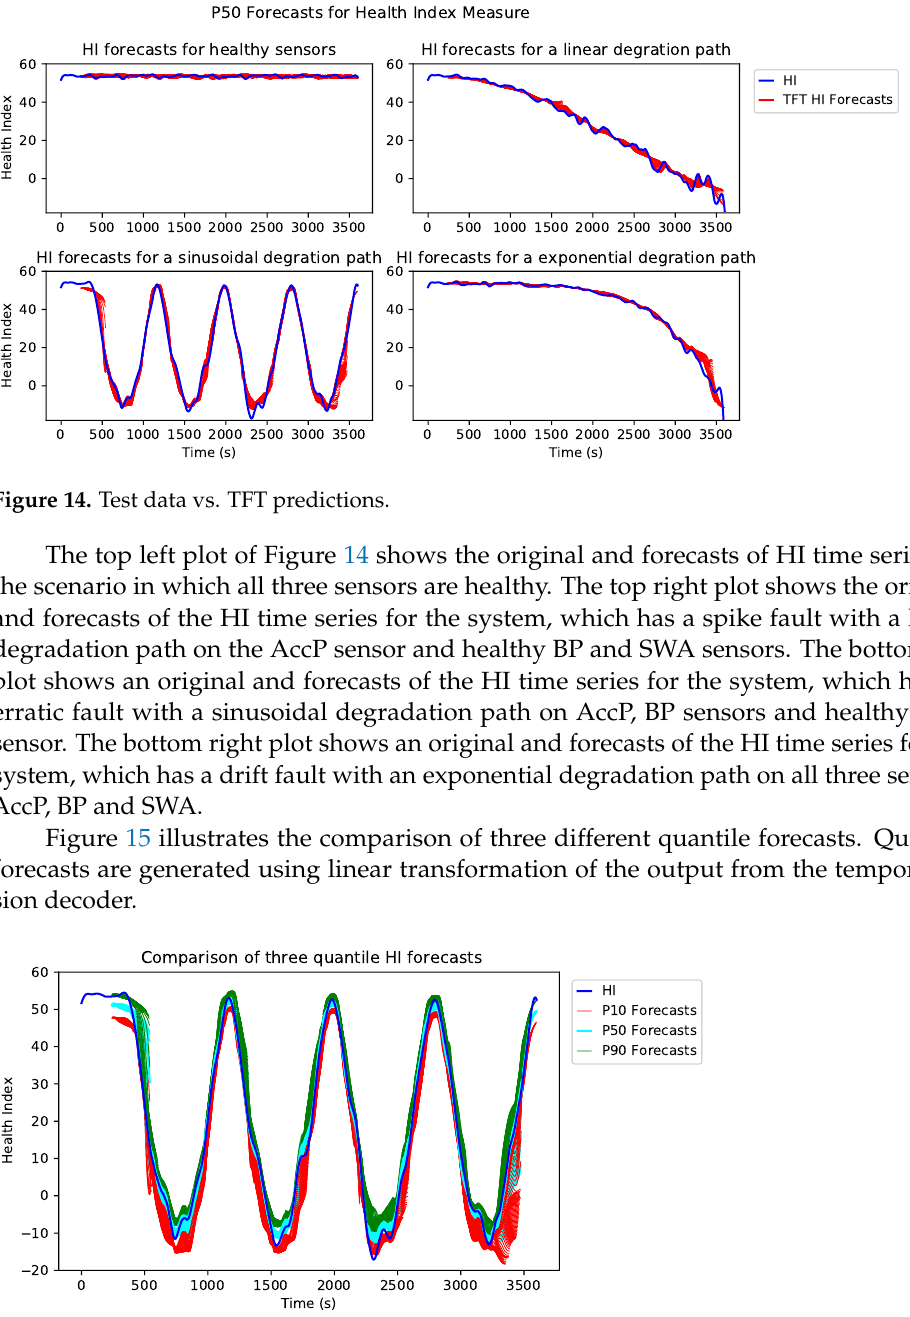
Figure 15. Test data vs. TFT forecasts for three different